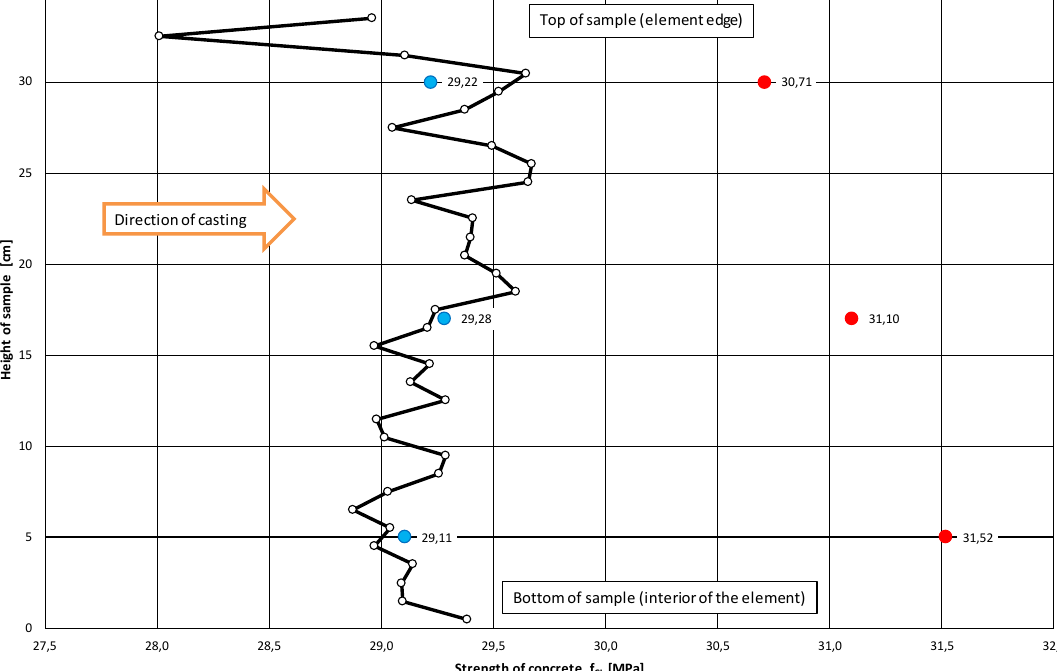
Figure 11. The mean distribution of compressive strength f CL of concrete along the height of the sample taken parallel with the top surface of the slab. The diagram includes the mean concrete strengths for the top, middle and bottom samples obtained from ultrasonic tests (marked blue) and destructive tests